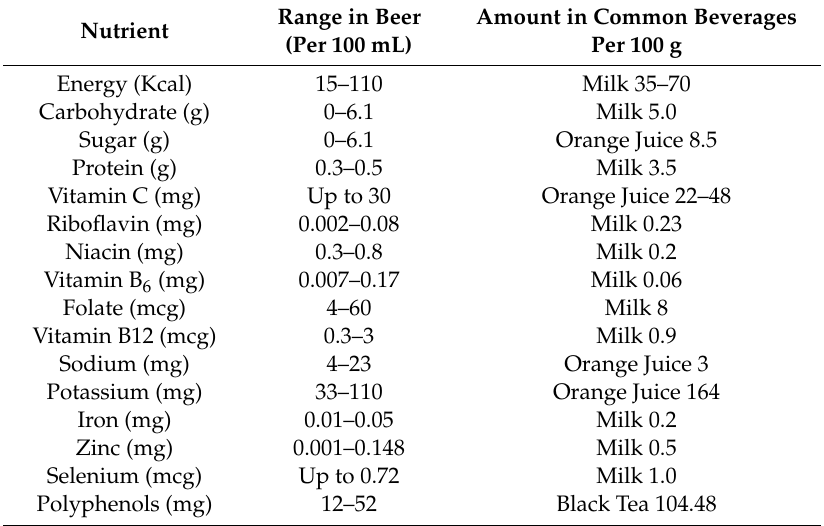
Table 1. The nutritional composition of beer and a comparison with other common beverages. The data are from